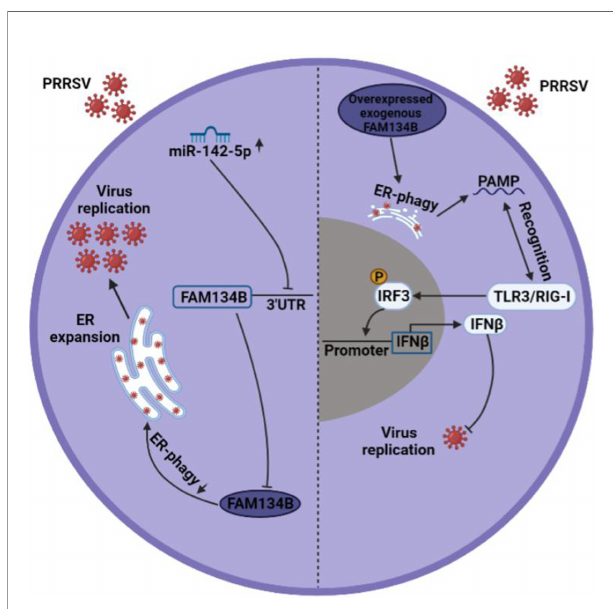
FIGURE 7 | Mechanism underlying PRRSV pathogenesis regulation by FAM134B. In normal setting, PRRSV infection downregulated the expression of FAM134B (dark blue) via under the action of miR-142-5p, thereby initiating ER expansion and promoting PRRSV replication. In the scenario of FAM134B overexpression, PRRSV might be digested by FAM134B-induced ER-phagy, thereby generating the PAMP, which was recognized by TLR3/RIG-I to activate innate immune response and inhibit PRRSV